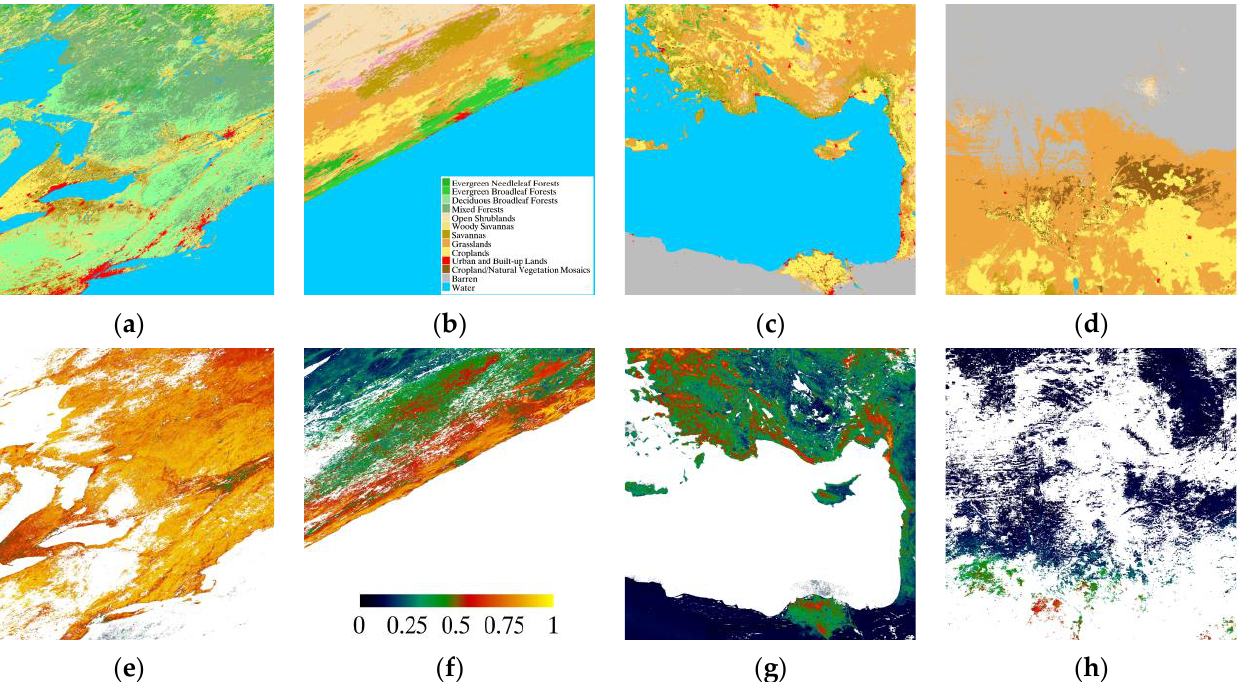
Figure 1. IGBP land-cover map ( a − d ) in 2010 and the NDVI ( e − h ) on DOY 170, 2010 over ( a , e ) h12v04, ( b , f ) h30v12, ( c , g ) h20v05, and ( d , h ) h18v07. The white area on the NDVI map represents pixels with no or low-quality data.